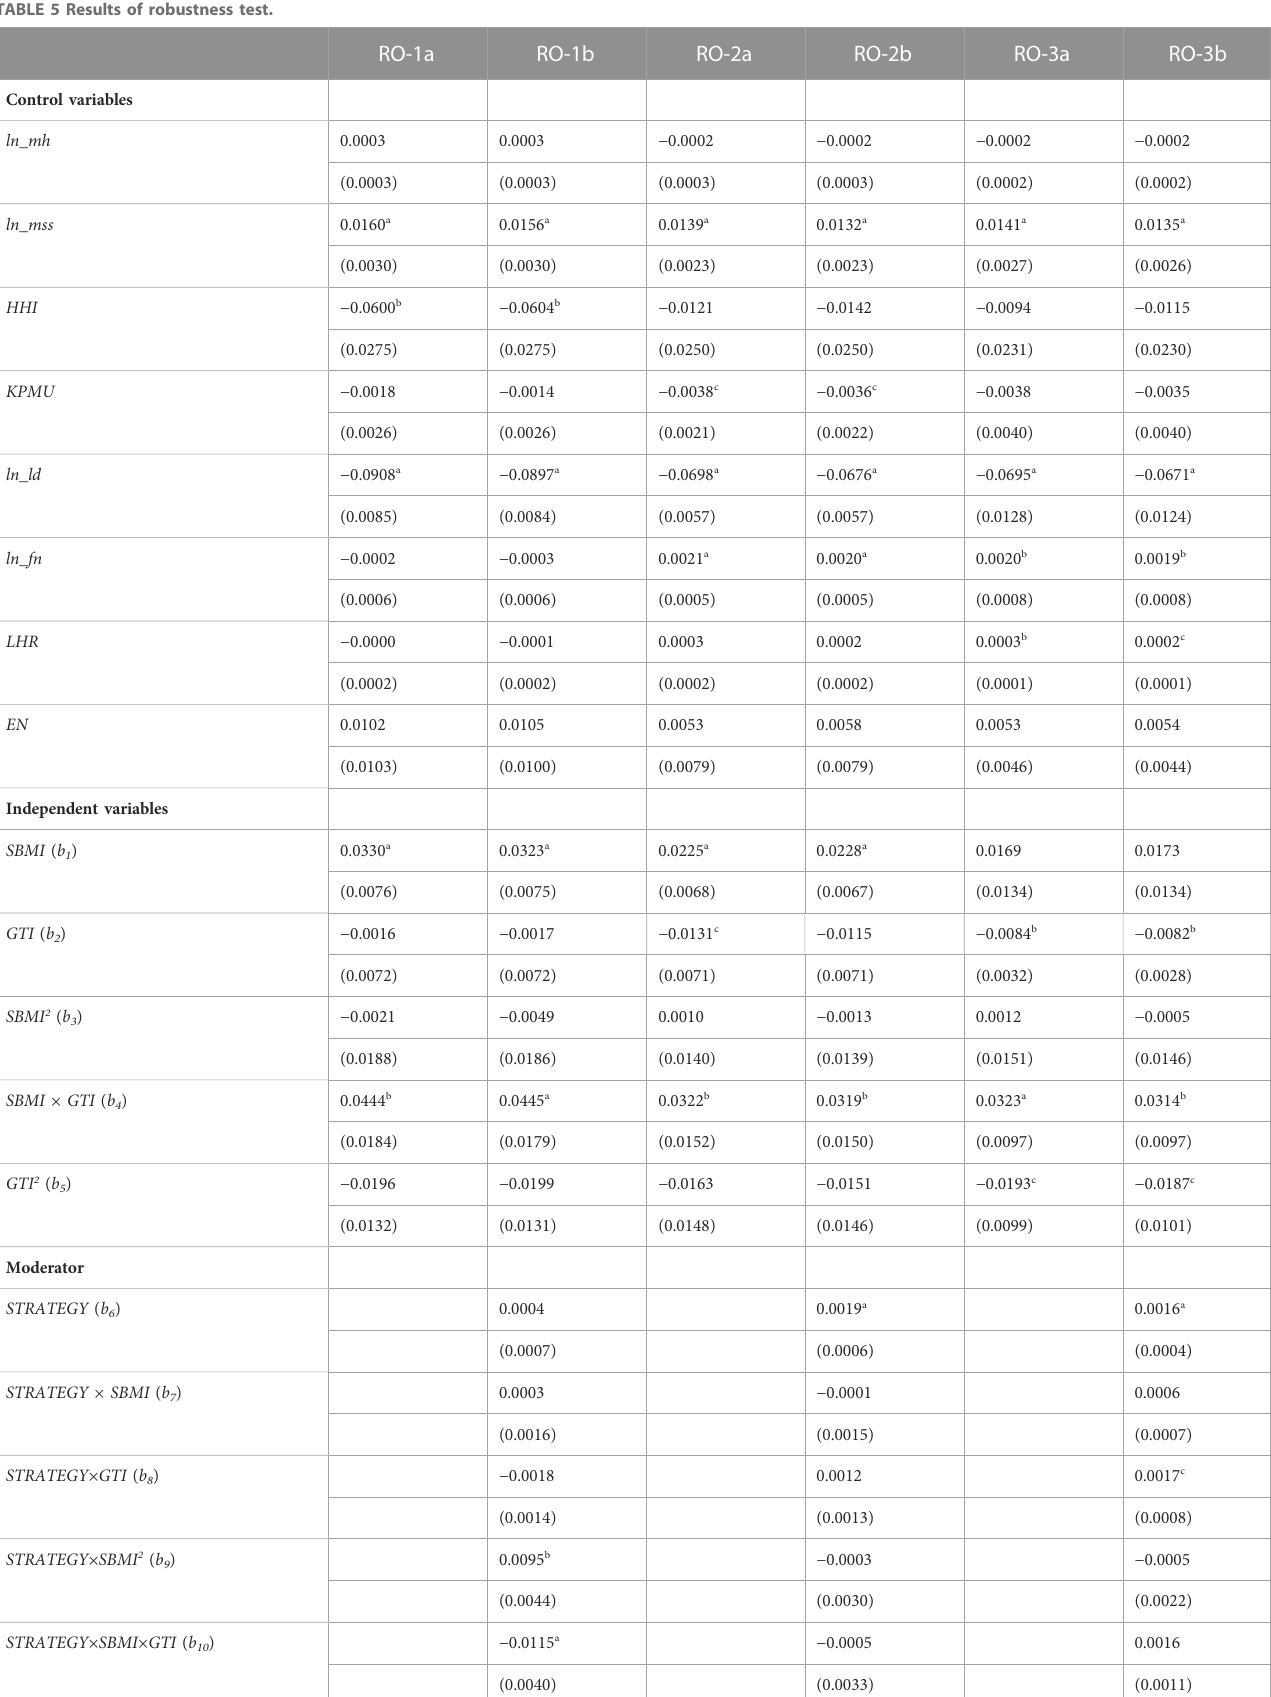
TABLE 5 Results of robustness